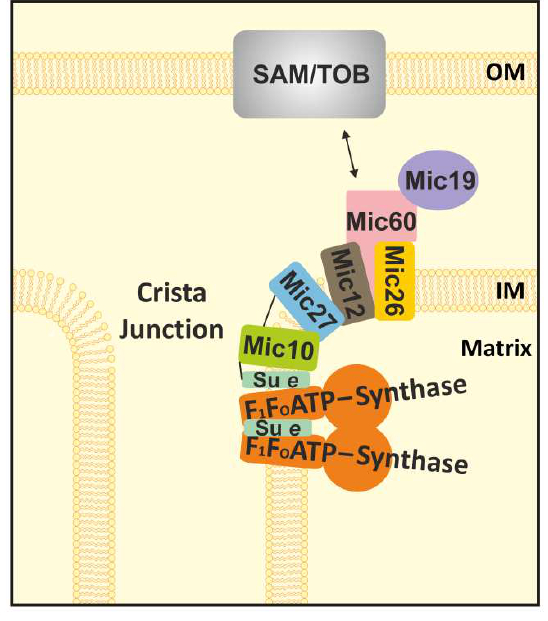
FIGURE 6: Model for the functional interplay between the MI- COS-complex and the F 1 F O -ATP synthase in yeast. Schematic representation of MICOS subunits in the mitochondrial inner membrane. Mic60 (pink) interacts (black arrow) via its C- terminus with protein complexes (grey) in the outer membrane (OM; e.g. the SAM-/TOB-complex). Mic27 (blue) mediates the interaction between Mic10 (green) and the remaining MICOS- complex. Mic10 interacts with part of the F 1 F O -ATP synthase (orange) via the dimer-specific F 1 F O -ATP synthase subunit e (Su e in pale green). Black lines indicate observed crosslinks. OM: out- er membrane, IM: inner